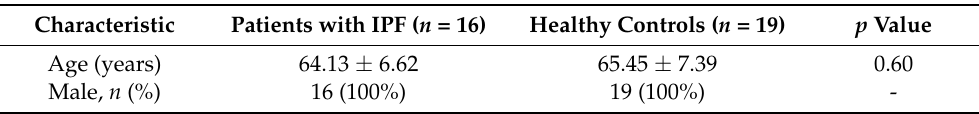
Table 1. Demographic and clinical characteristics of healthy controls and patients with IPF (Th9 cells in PBMC).